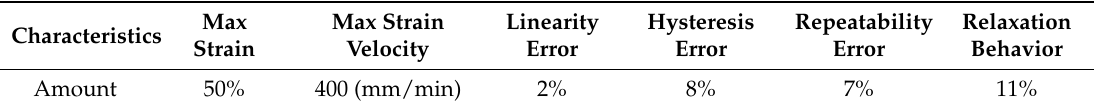
Table 1. Calibration results of BWS [29].